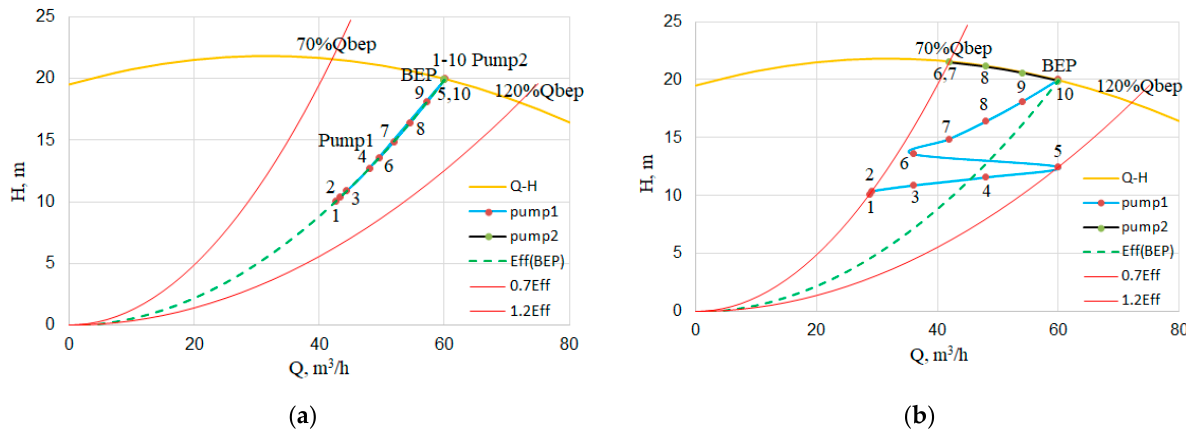
Figure 5. ( a ) Q-H characteristics of the pump, hydraulic system curve, and BEP curve in the case of the maximum reliability control; ( b ) for the case of the trade-off control: yellow line is Q-H curve of the pump at 2900 rpm; red lines are the POR region boundaries; green line is the BEP curve; blue line is the pump 1 operating points; and black line is the pump 2 operating points.